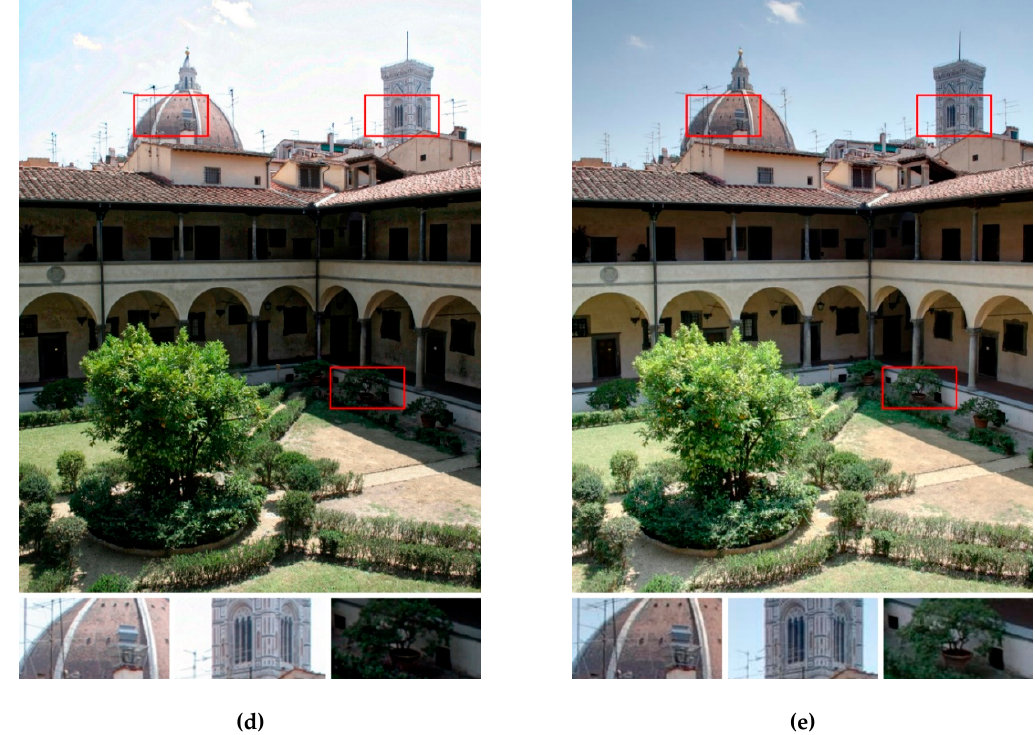
Figure 7. Visual comparison of the exposure fusion results using the test image Laurentian Library . ( a ) Results from the method in Reference [5]. ( b ) Results from the method in Reference [6]. ( c ) Results from the method in Reference [28]. ( d ) Results from the method in Reference [23]. ( e ) Results from the proposed method. The enlarged versions of the red rectangles are provided to illustrate the subtle differences.